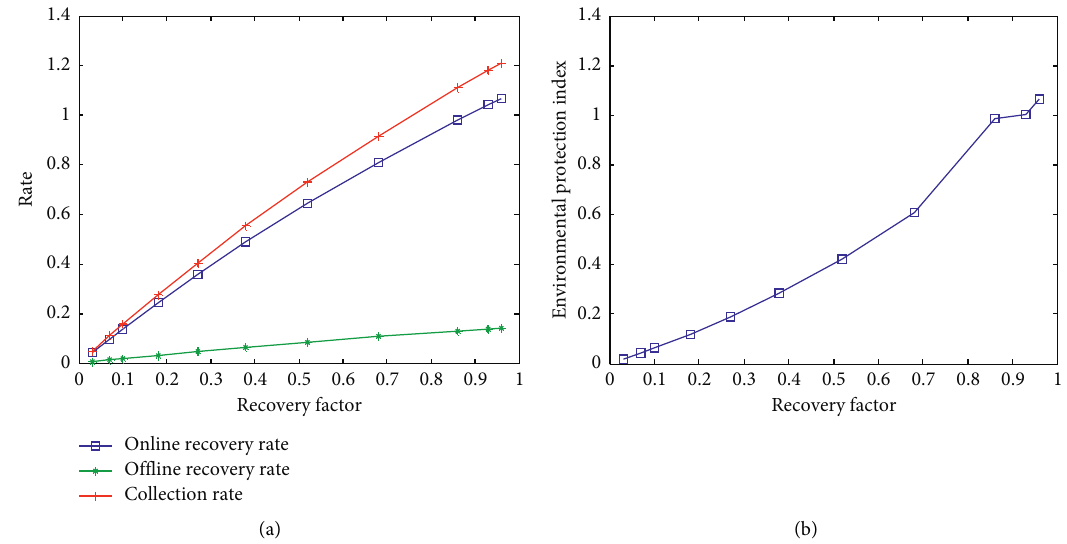
Figure 14: Simulation results of the recycling factor as an influencing factor. (a) Recovery factor and rate. (b) Recovery factor and environmental protection